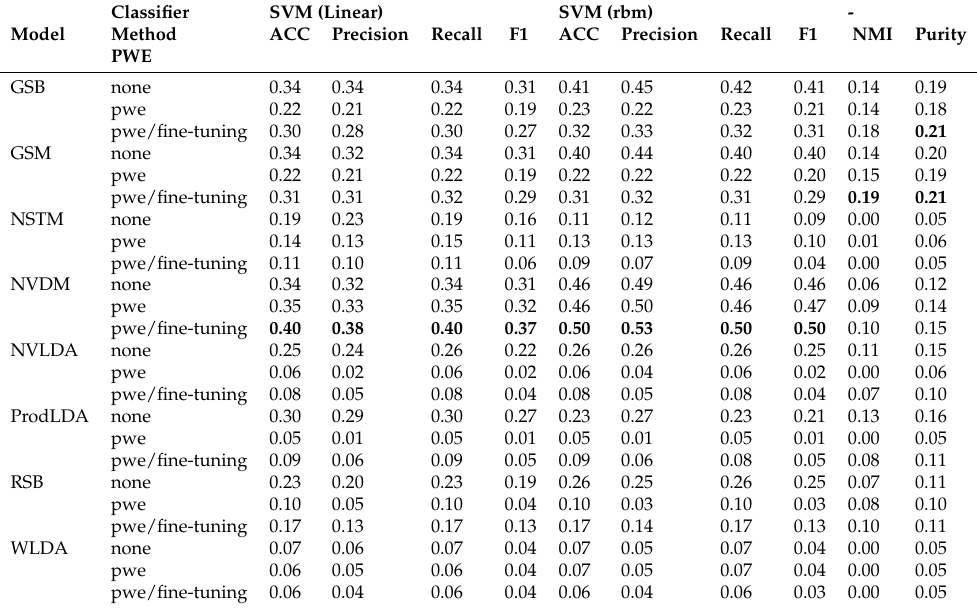
Table 29. Classification and Clustering performance on